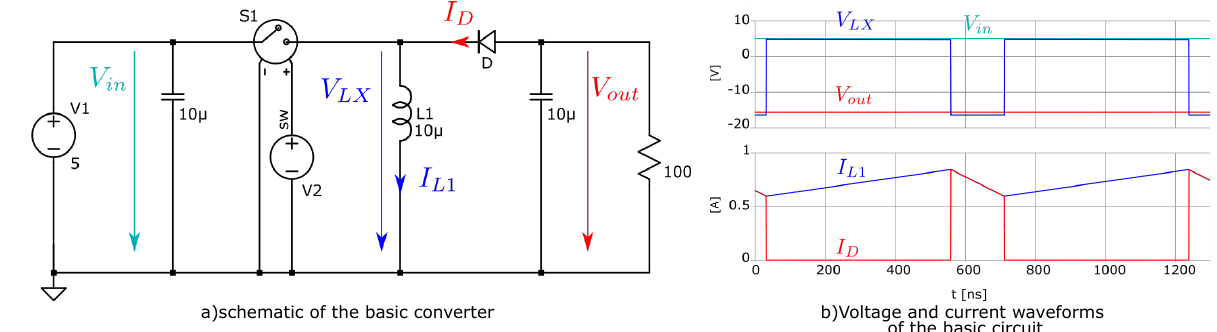
Figure 4. Basic converter model with ideal components.